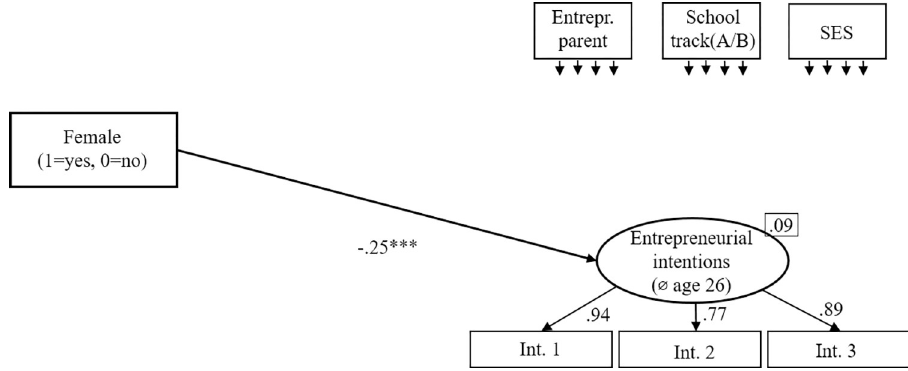
Fig 1. The gender gap in entrepreneurial intentions: Direct effects of gender on entrepreneurial intentions in adulthood. Standardized coefficients are given. R 2 is shown in the upper right corner of the dependent variable. Correlations between the control variables were allowed. � p < .05; �� p < .01; ��� p < .001.